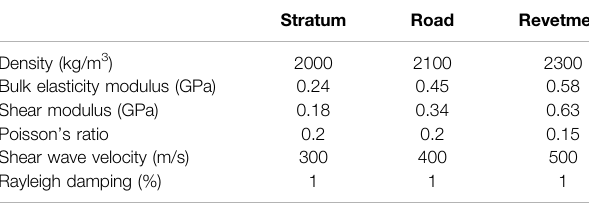
TABLE 2 | Material properties for the FLAC numerical